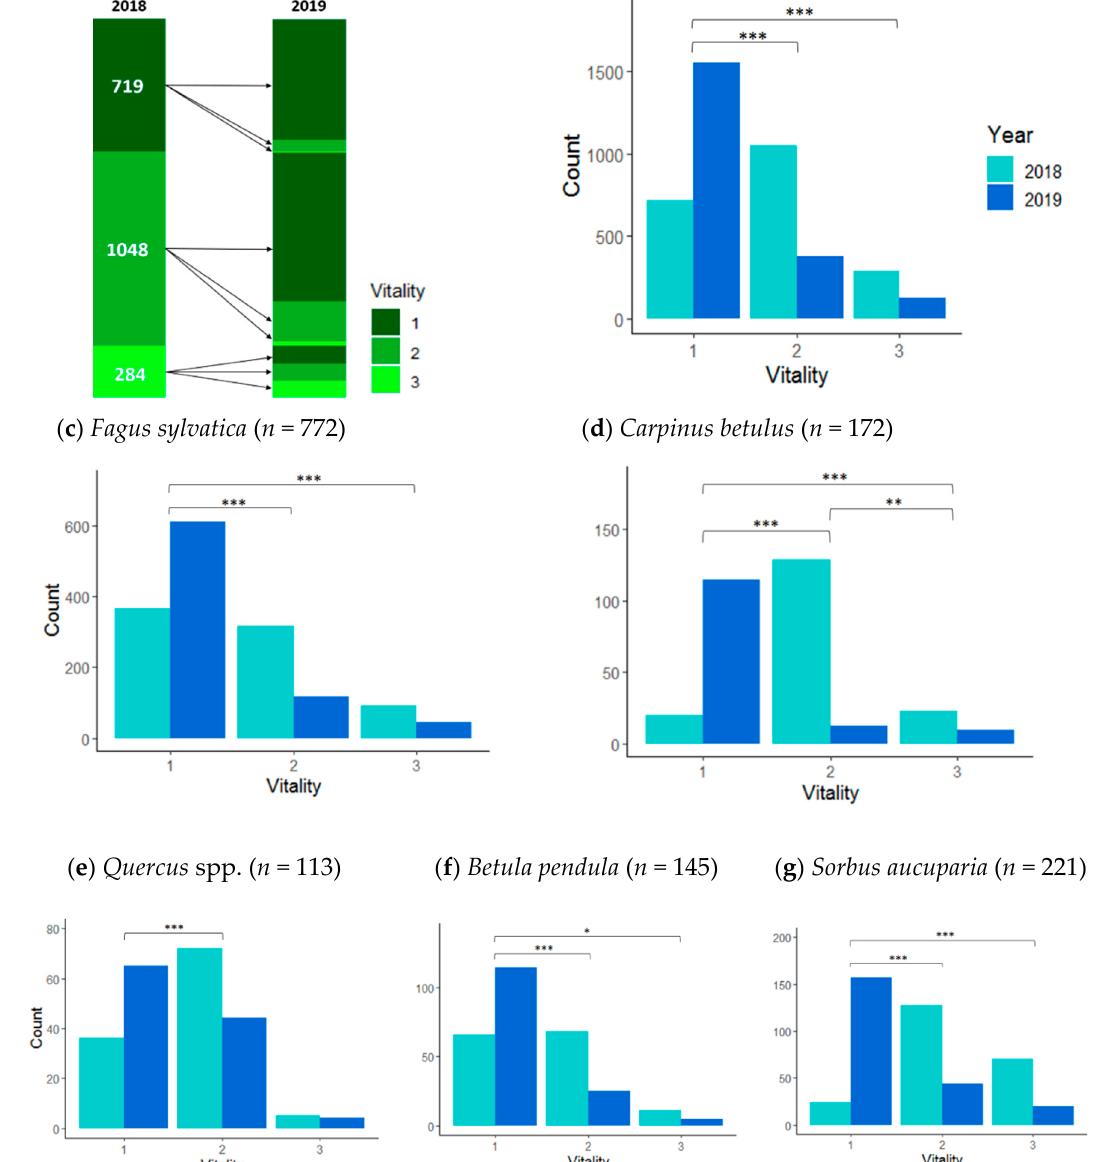
Figure 3. Vitality classes of all saplings ( n = 2051). ( a ) Assessment of sapling vitality and their survival after the drought of 2018. The barplot on the left (2018) shows the fraction of saplings belonging to each category of vitality measured in 2018. The barplot on the right (2019) shows the fraction of saplings that have retained the same vitality, increased, or decreased their vitality. ( b ) Di ff erences in sapling vitality classes between 2018 and 2019 for all saplings. ( c – g ) Vitality of Fagus sylvatica , Carpinus betulus , Quercus spp., Betula pendula , and Sorbus aucuparia in 2018 and one year later (2019). Vitality 1 = undamaged, 2 = partly damaged, 3 = completely damaged saplings. Stars show the statistically significant di ff erence between vitality groups based on Fisher’s exact test (* p < 0.05, ** p < 0.01, *** p < 0.001). At species level, there were significant di ff erences in vitality between the species. Of the 10 abundant species, F. sylvatica and B. pendula recorded the least damage. The most a ff ected